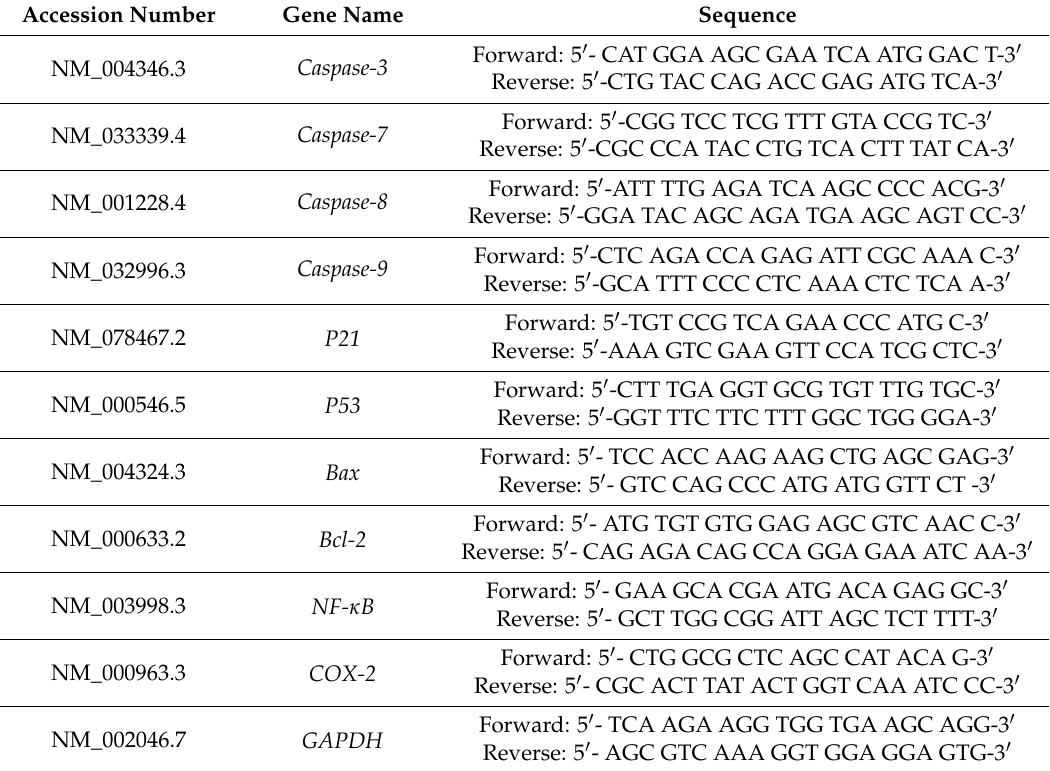
Table 1. The sequences of reverse transcription-polymerase chain reaction primers used in this